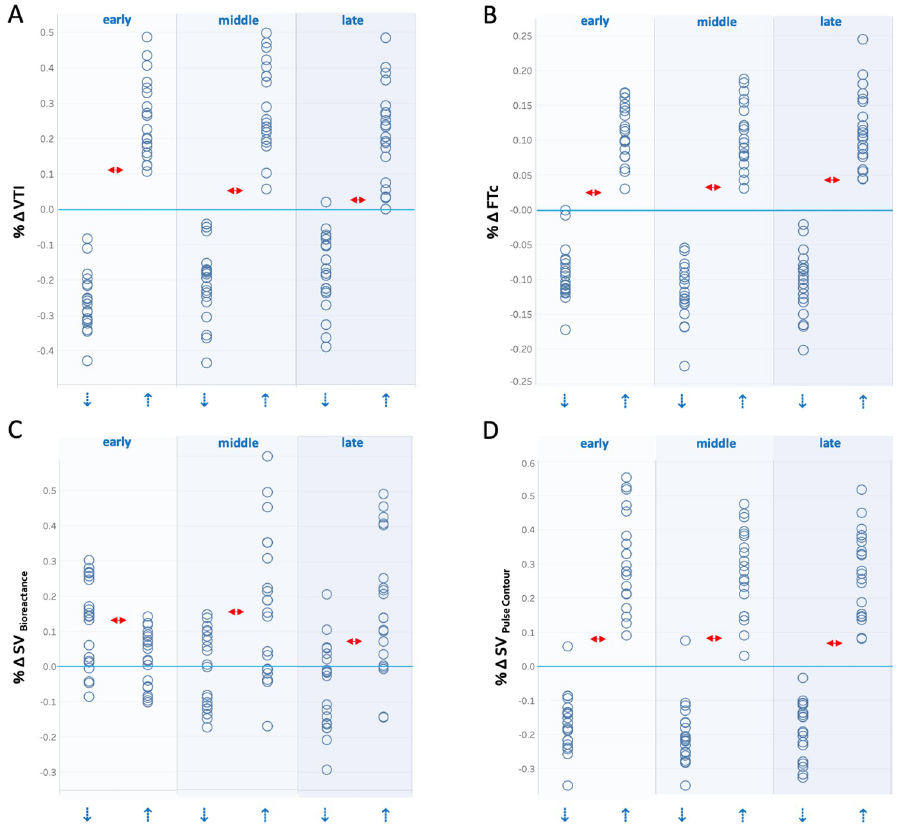
Fig 3. Dot-plots for each metric across all 3 temporal windows (early, middle, late). Horizontal, blue line is baseline for each measurement. The blue arrows represent directional change in preload. Y-axis is fractional change (% Δ ) for each metric relative to baseline. A is velocity time integral (VTI) from the wearable Doppler, B. is corrected flow time (FTc) from the wearable Doppler, C. is stroke volume from bioreactance (SV Bioreactance ) and D. is stroke volume from non-invasive pulse contour (SV Pulse Contour ). The small, horizontal red arrows represent optimal diagnostic threshold for each metric. See Table 1 for threshold values.